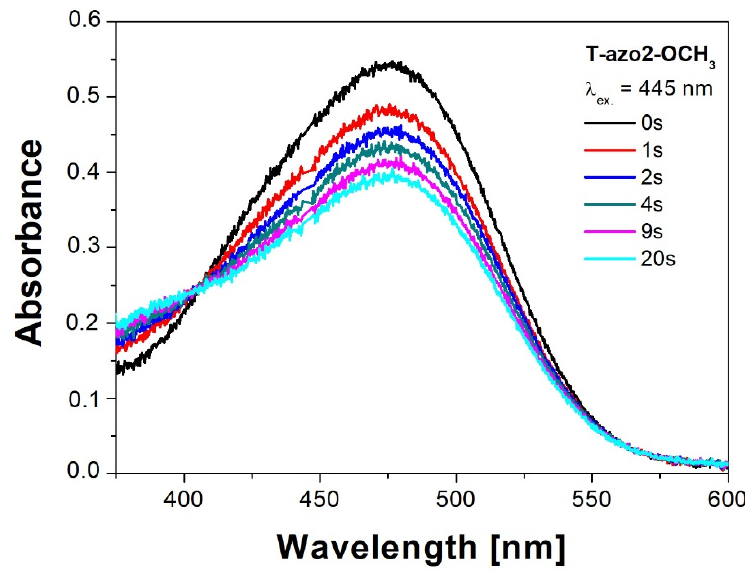
Figure 2. Absorption spectra of T–azo2–OCH 3 before (0 s) and during irradiation (1 s–20 s) with 445 nm.